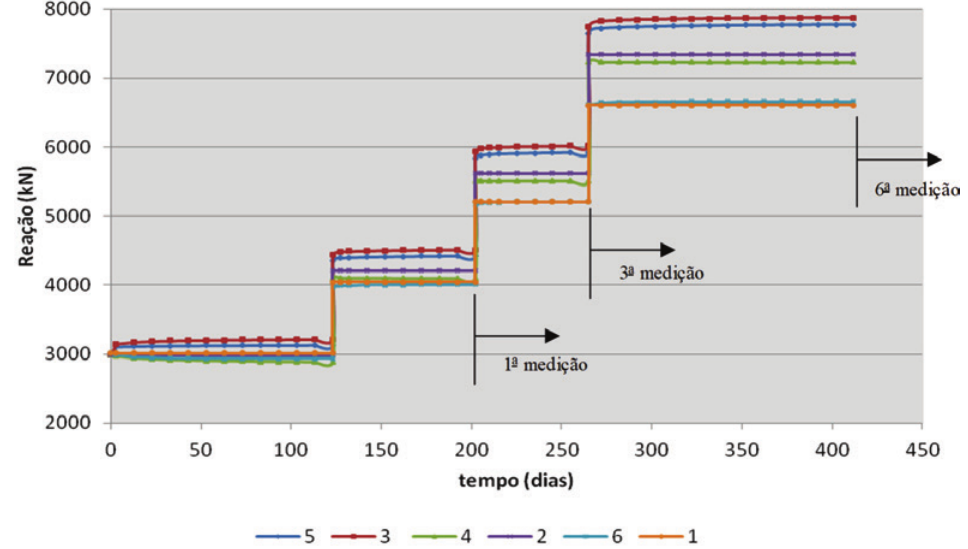
As Figuras 10 e 11 apresentam as curvas de esforços normais de dois pilares (M5 e M22) ao longo do tempo, para as situações 1 a 6, enumeradas acima. Nestas figuras estão também identificadas, para melhor clareza, as etapas das medições.